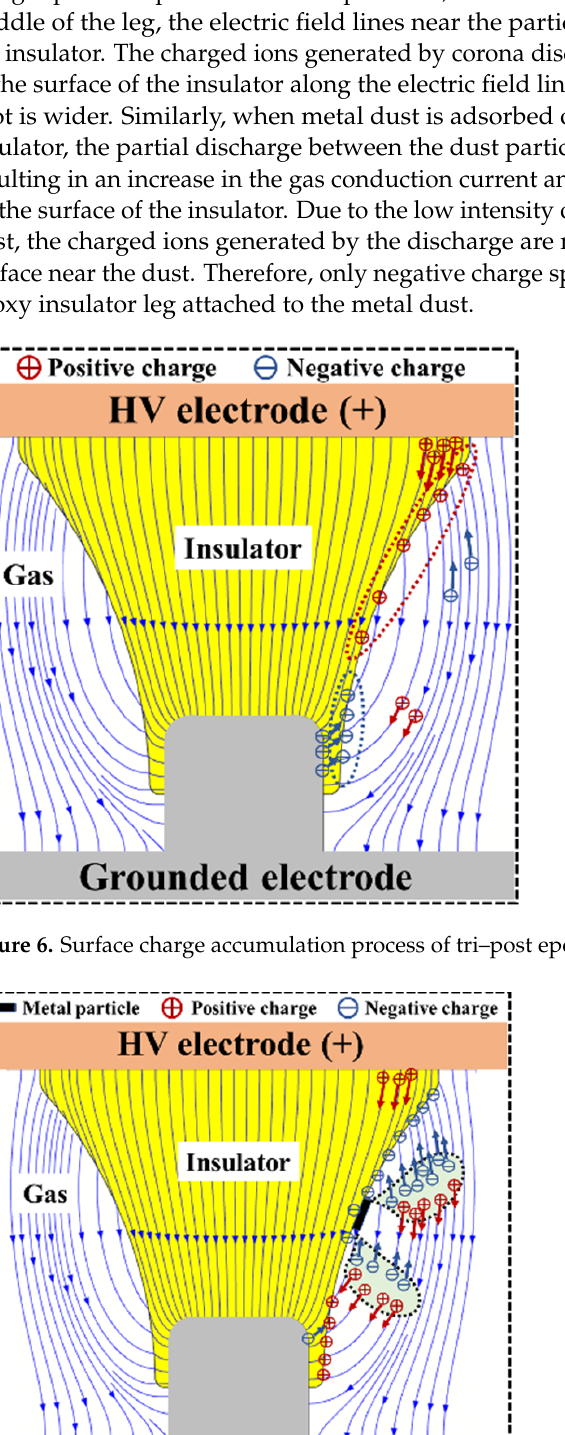
Figure 7. Surface charge accumulation process of tri–post epoxy insulator with metal particle at- tached.